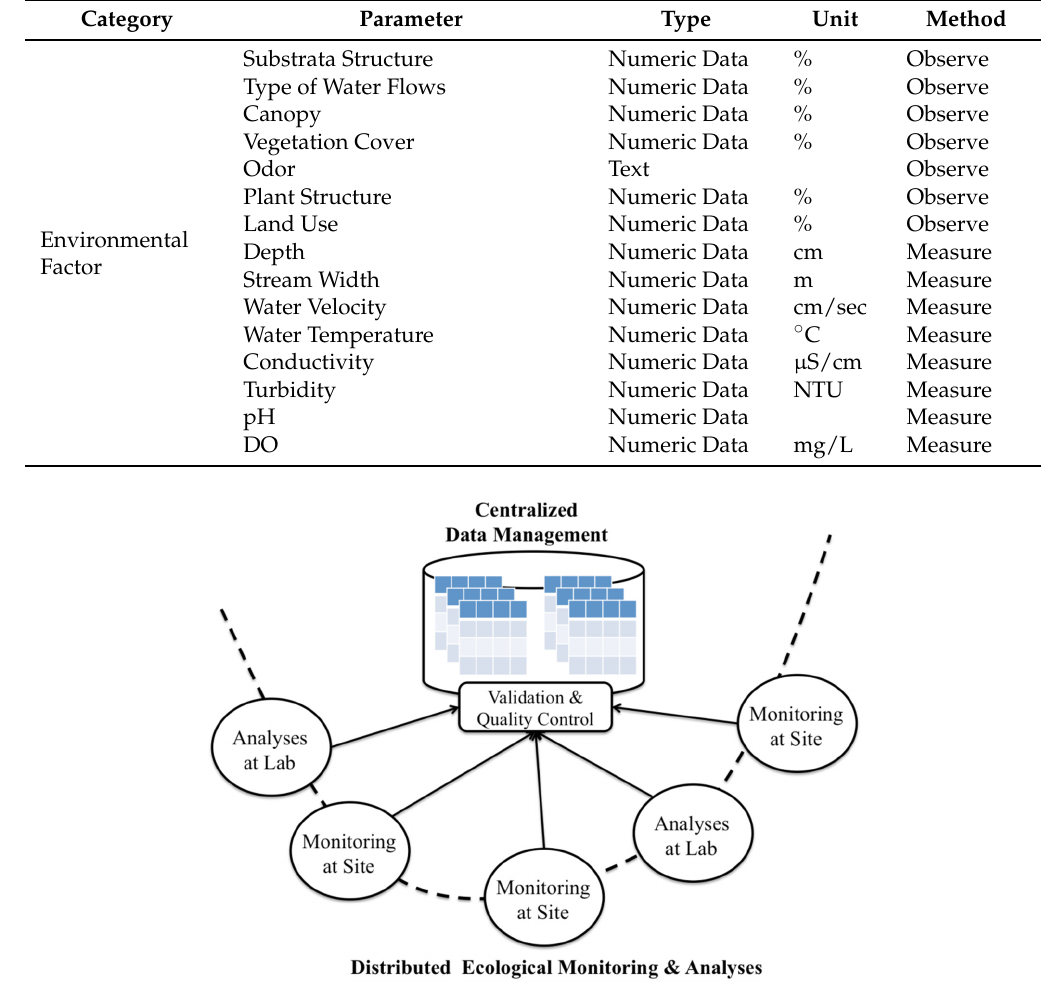
Figure 2. NAEMP data collection and management structure.